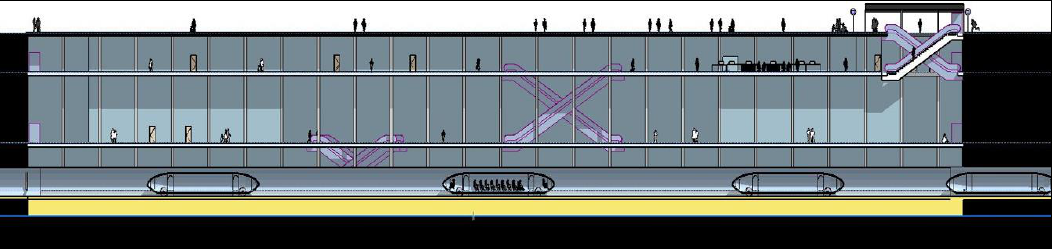
Figure 11. Functioning and operations in the hyperloop station building.